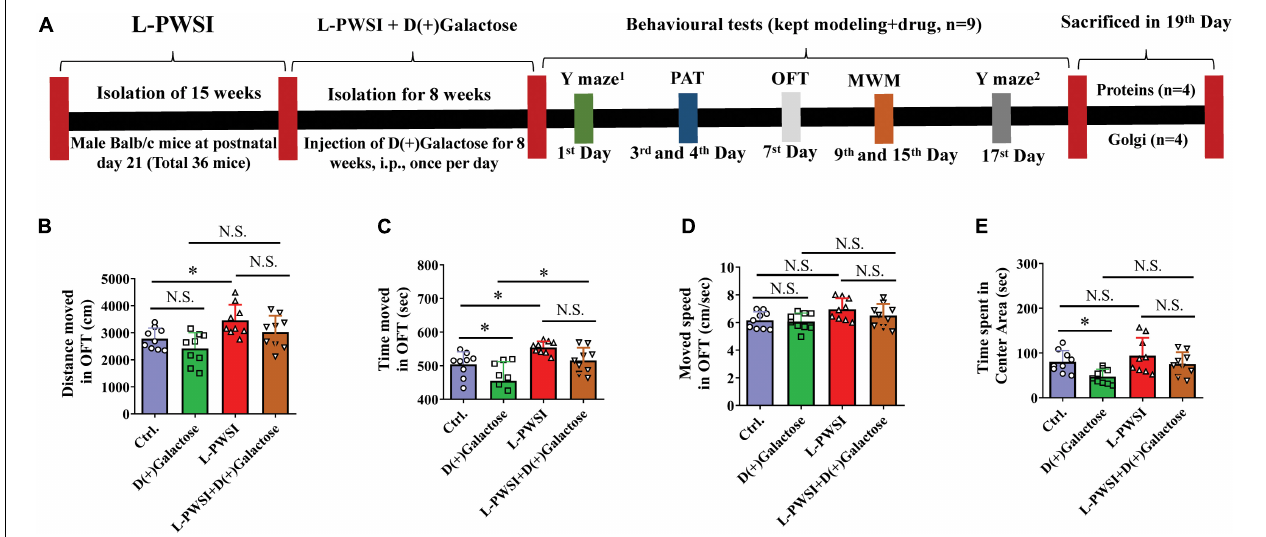
FIGURE 1 | Experimental timelines and open field test (OFT) results to reflex the exploratory activities and anxious behaviors. (A) Experimental timelines. The long-term post-weaned social isolation (L-PWSI) mice were individually housed from postnatal day 21 for 15 weeks, and the control mice were group housing. In the course of modeling the L-PWSI (8 weeks), mice were injected with D(+)Galactose till the end of 15 weeks of L-PWSI. After the modeling, the animals underwent weeks of behavioral testing (the L-PWSI mice were still isolated) i.e., Morris Water Maze, Y-maze, and Passive avoidance tests. The mice were allowed to rest every other day during the behavior testing. At the end of the experiment, animals were sacrificed and samples were collected for western-blot and Golgi. The results of the OFT show anxiety measures. (B) Means of distance moved, (C) time moved, (D) movement speed, and (E) the time spent in the center zone in the OFT. Data are presented as the mean ± SEM from nine mice in each group. ∗ represents p < 0.05; N.S., represents no